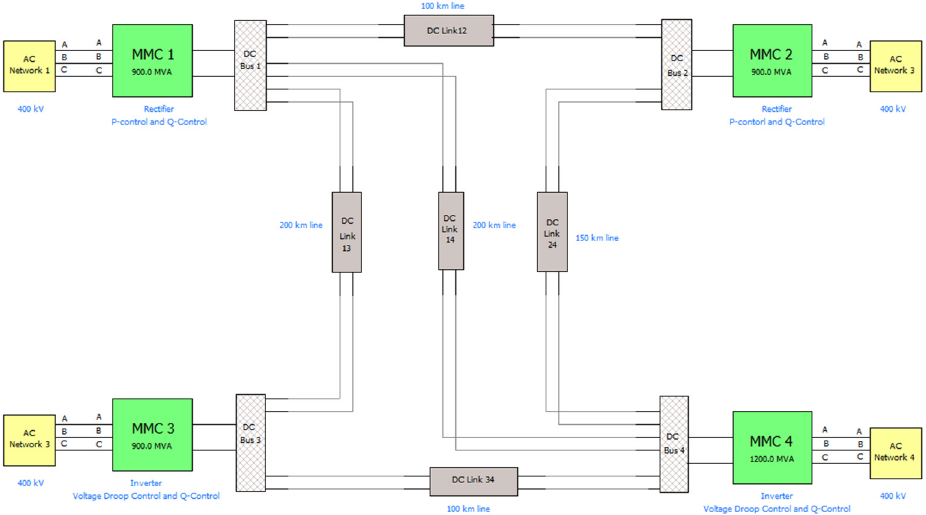
Figure 7. Model in PSCAD of the four-terminal HVDC system employed in the study case. The proposed protection system is evaluated against different fault conditions.